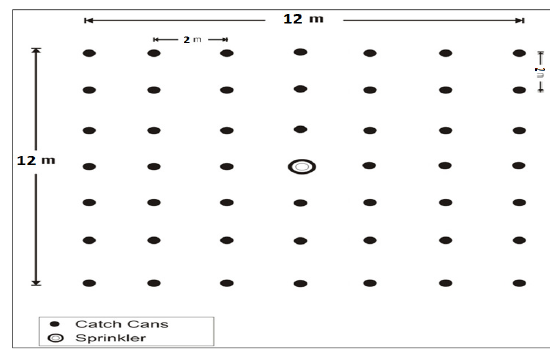
Fig. 1: Layout of Catch-Cans around a Sprinkler